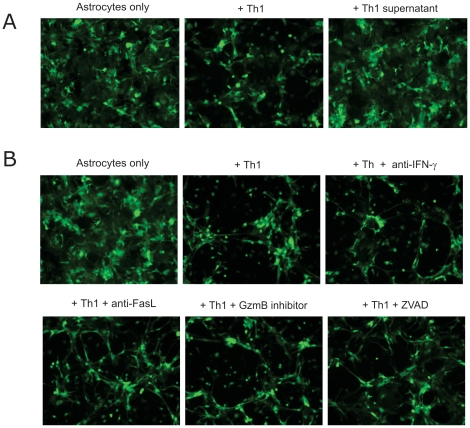
Effect of blockade of cytotoxic molecules on Th1 mediated astrocyte cytotoxicity.2D2 MOG-specific Th1 cells were co-cultured in duplicates for 48 hours with astrocytes in the presence or absence of the Th1 culture supernatant (A), anti-IFN-γ antibody, anti-FasL antibody, Granzyme B (GzmB) inhibitor and the pan-caspase inhibitor ZVAD (B). Cells were tracked every 30 minutes by fluorescent time-lapse microscopy. Shown is the snap-shot fluorescent picture at the end of the culture period and is representative of minimum 2 experiments.